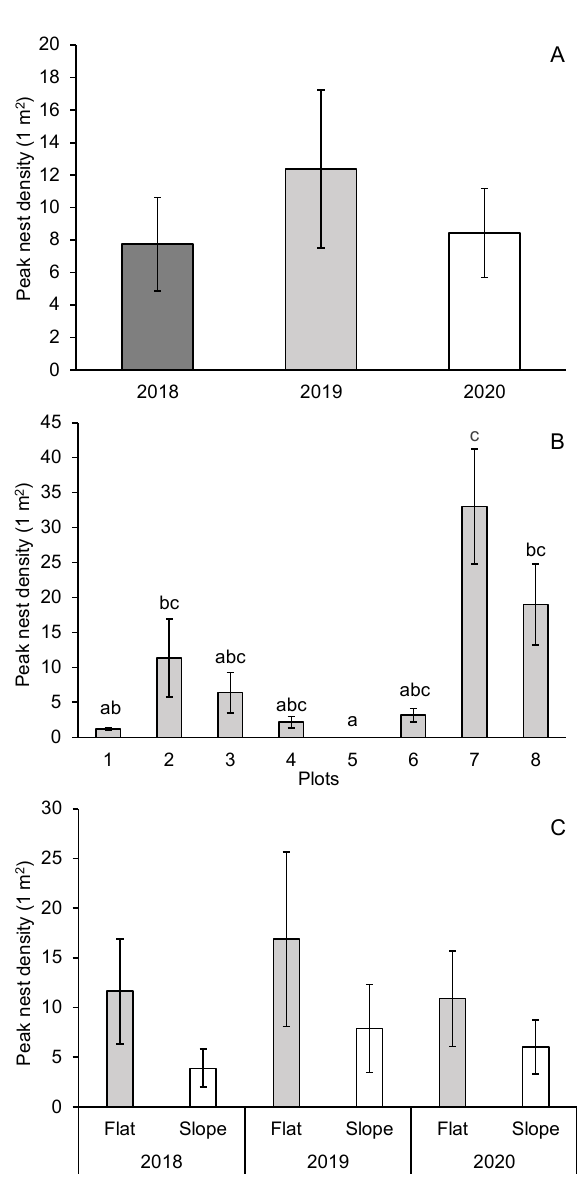
Figure 2: (A) Mean (± SE, N = 8) peak nest density for ground-nesting bees in artificially created nesting plots in 2018, 2019 and 2020. Peak nesting density was used because nest identification varies at each assessment depending on recent rain events, which can destroy the tumuli. There was no difference between years. (B) Mean (± SE, N = 8) peak nest density for ground-nesting bees in artificially created nesting plots over three years (2018 – 2020). Different letters indicate significant differences between plots ( P < 0.05) according to Dunn's Test of Multiple Comparisons. (C) Mean (± SE, N = 8) peak nest density on the artificially created nesting plots over three years (2018 – 2020) on the flat and 10-degree sloped area. There was no difference between the flat and slope